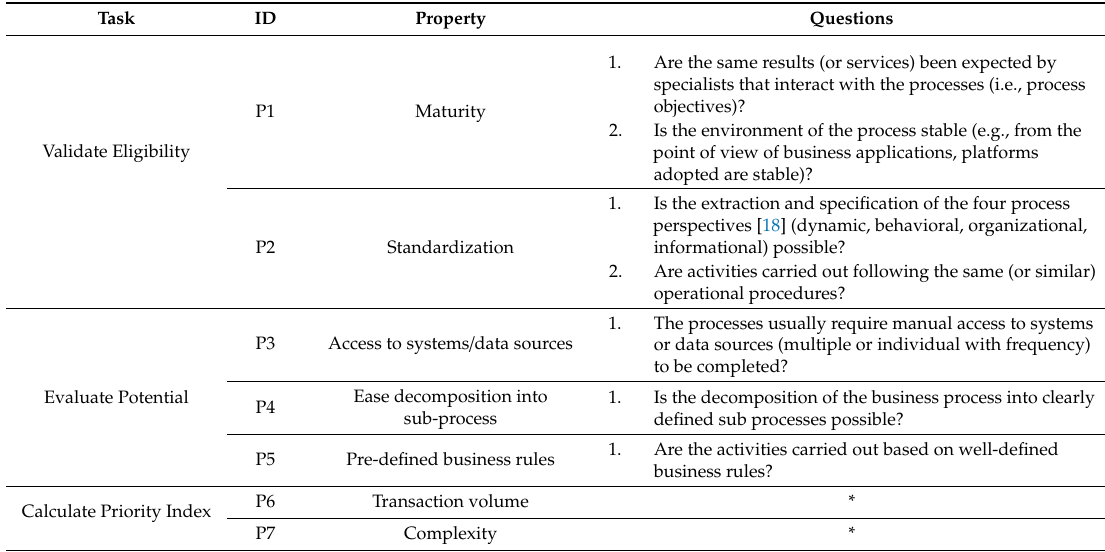
Table 5. Properties and questions adopted in each task of the classification